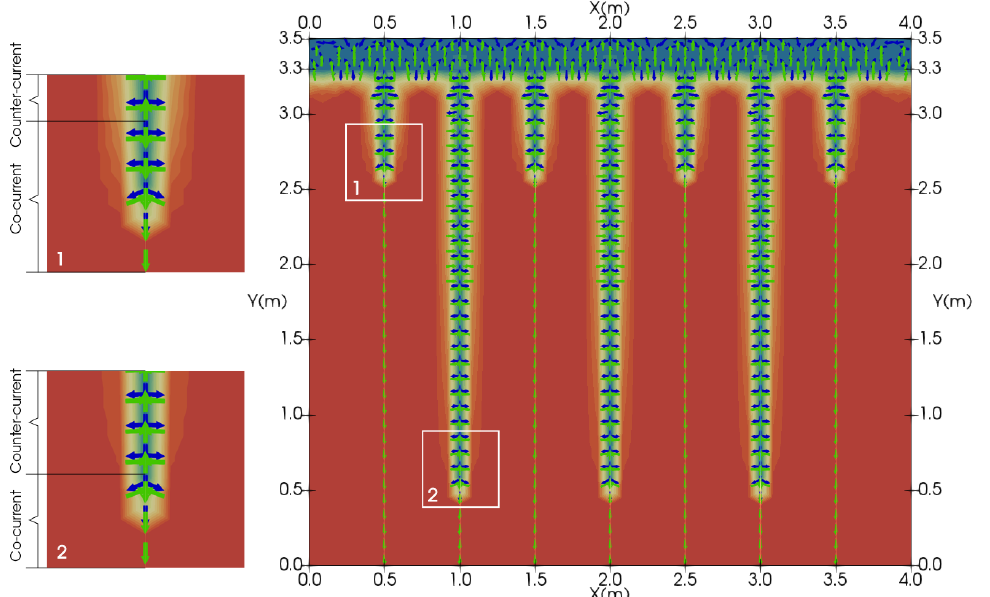
Figure 18. Flow patterns of water and air near the wetting front in an initially dry version of model TUFF2D after 10 min of intense rainfall (Case B). Co- and counter-current flow at the wetting front are shown in the inserts on the left. Phase velocity is displayed in blue for water and green for air. Only phase velocities greater than 10 − 6 m/s are